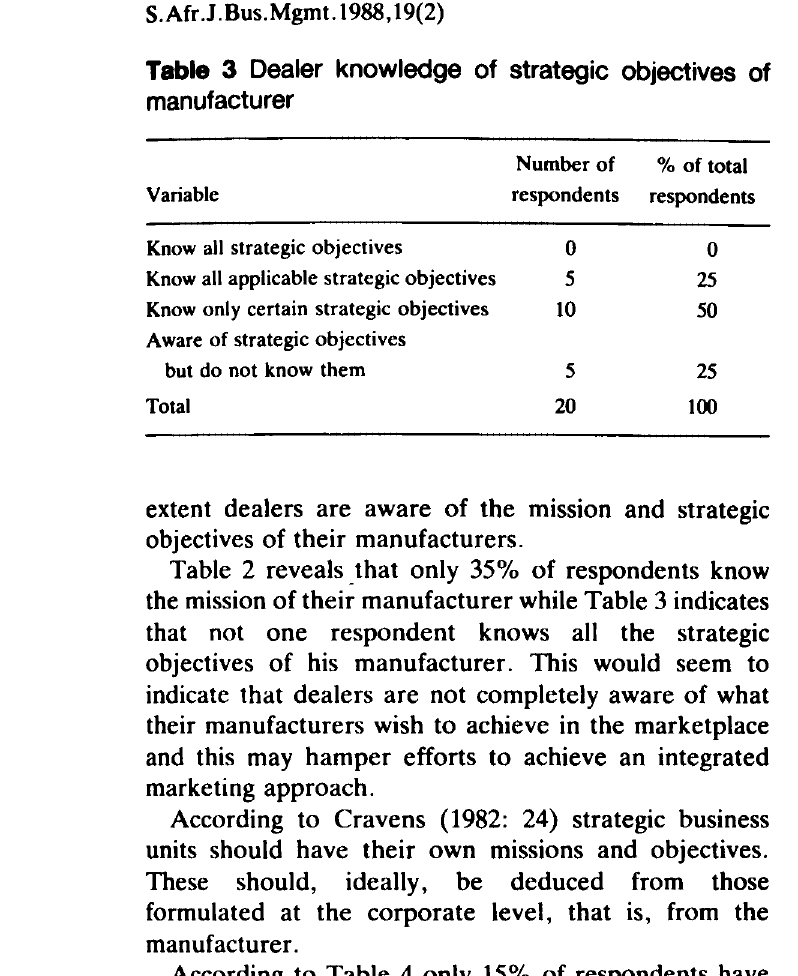
Table 3 Dealer knowledge of strategic objectives of manufacturer